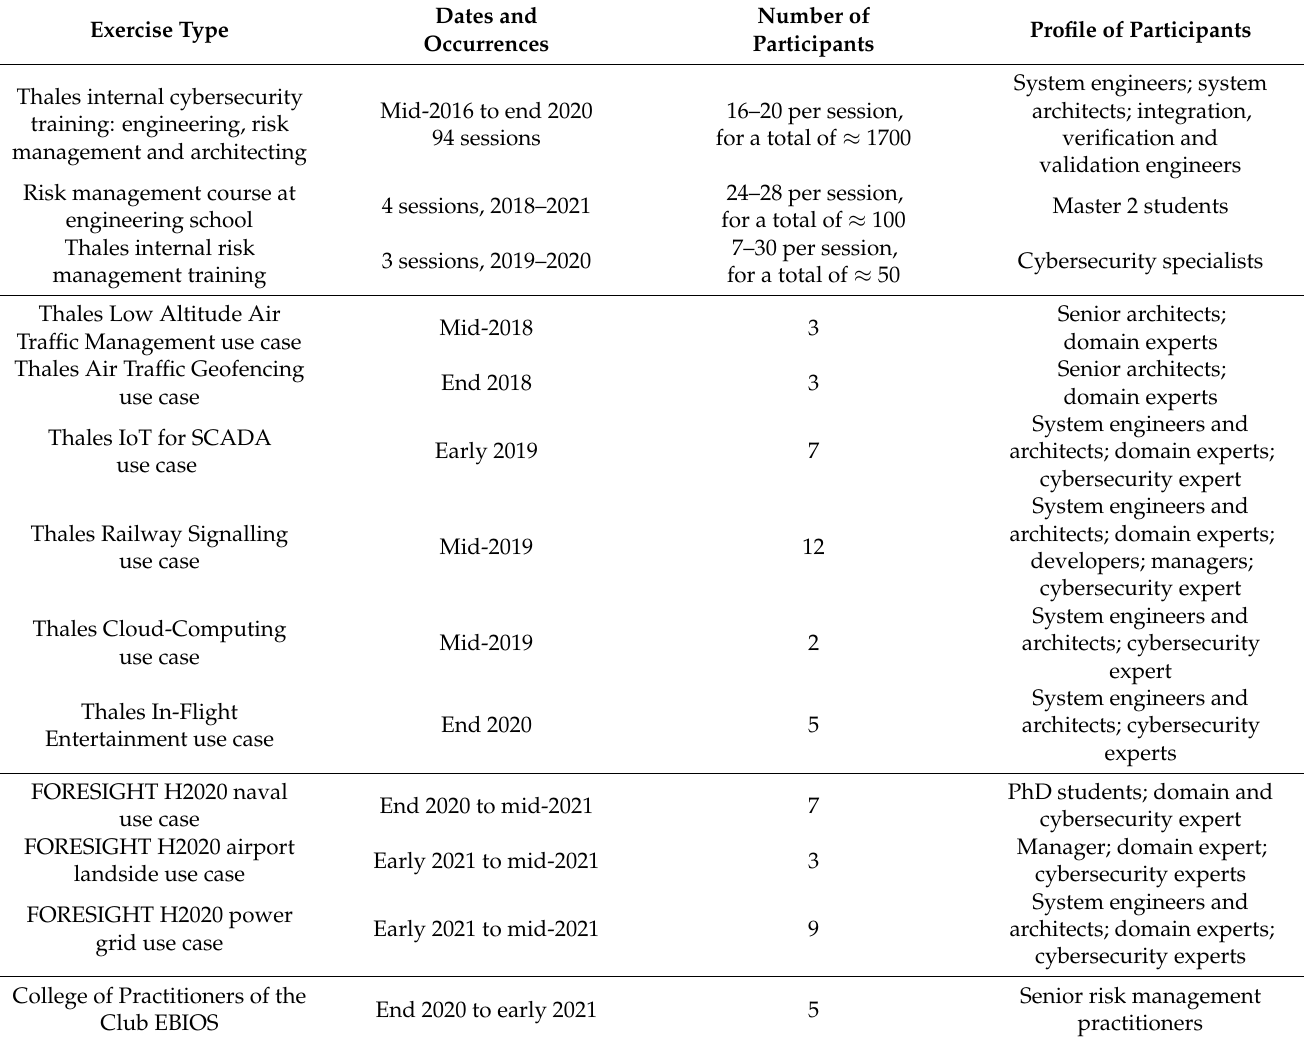
Table 1. Ob é risk validation contexts and participants (training and use